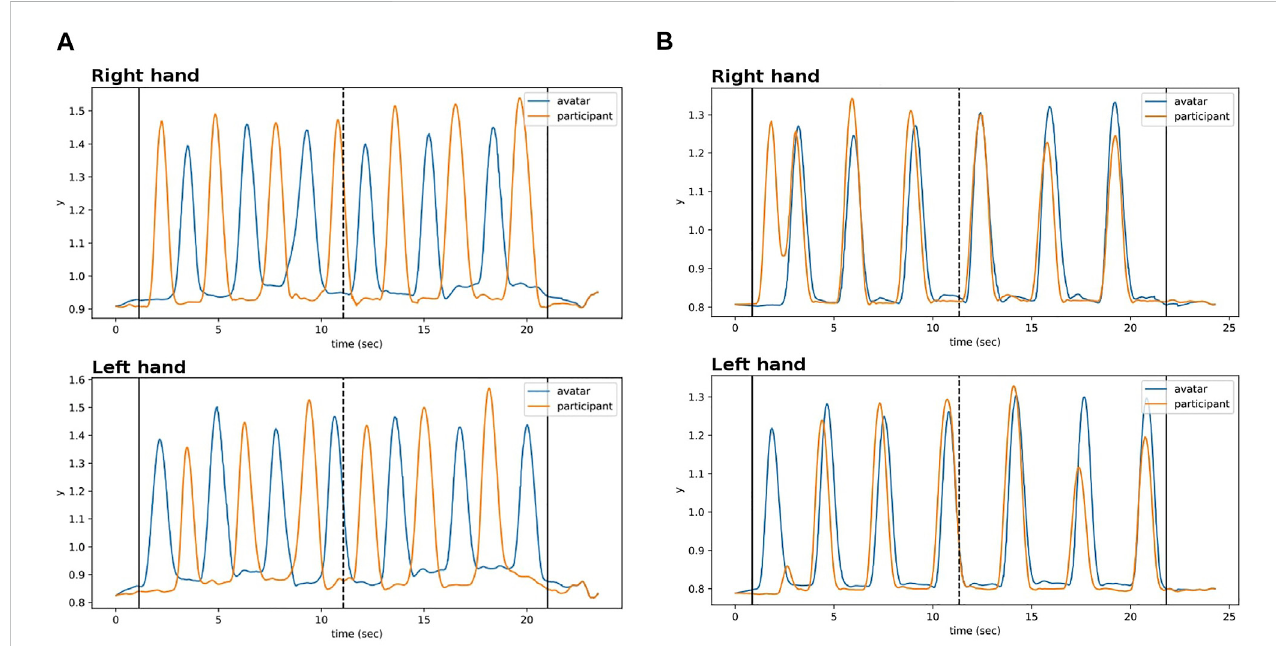
FIGURE 3 (A) Example trial classi fi ed as no FE (Pearson correlation for each hand ≃ − 0.5): the participant kept the same rhythm during the trial and did not synchronizewiththereplayedmovement. (B) Exampletrialclassi fi edasFE(Pearsoncorrelationforeachhand ≃ 0.9):theparticipantmovementsmatchedthe avatar replay from the second replayed raising movement until the